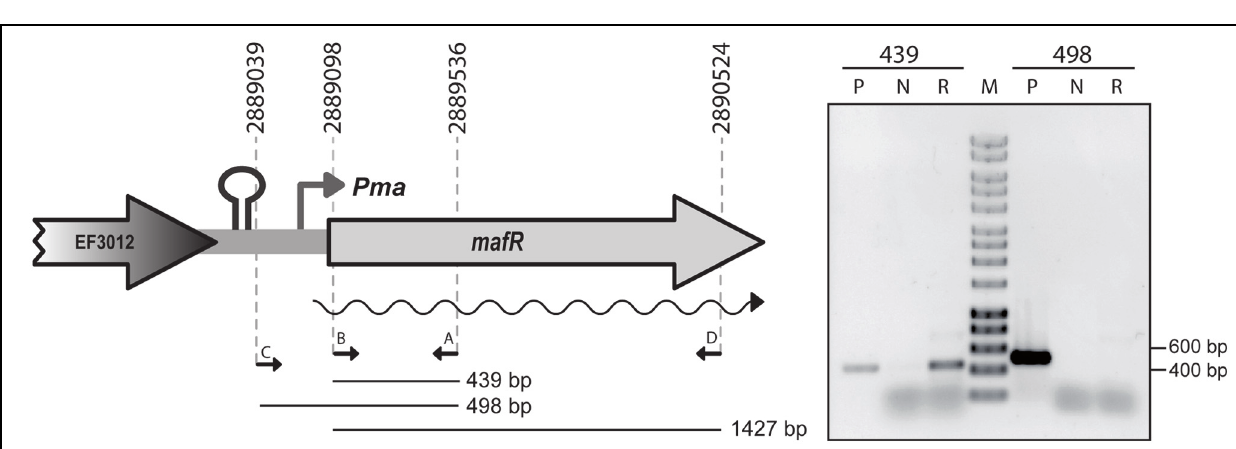
FIGURE 2 | Transcription of mafR in vivo . RT-PCR assays were performed using total RNA from V583 cells. The position of the four primers (A–D) used in the experiment is shown. RT-PCRs samples (lanes R) were analyzed by agarose (0.8%) gel electrophoresis. The sizes (in bp) of the DNA regions amplified by PCR using chromosomal DNA and the corresponding pair of primers (lanes P; positive control) are indicated. RT-PCRs without adding the reverse transcriptase were also performed (lanes N; negative control). The sizes (in bp) of DNA fragments (lane M) used as molecular weight markers (HyperLadder I, Bioline) are indicated on the right of the